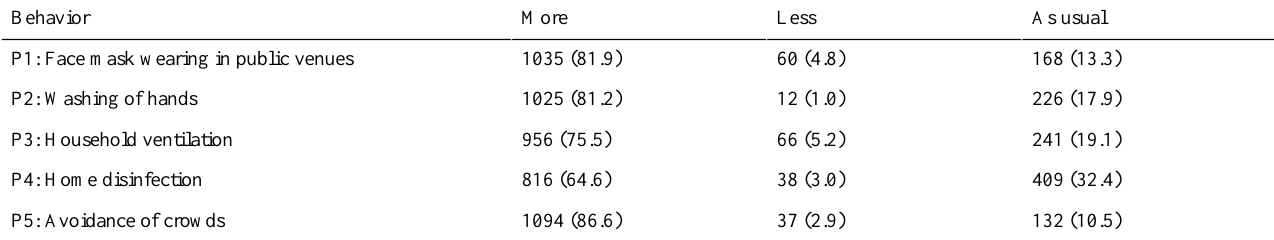
Table 2. Participants’preventive behavior changes in response to the COVID-19 pandemic in the past week (N=1263), n (%). Questions were answered using the following scale: 1=less, 2=as usual, and 3=more. For the total behavior score, we calculated how many specific behavior changes each participant endorsed. The range of the behavior scores was 7-15, and the mean score was 13.73 (SD